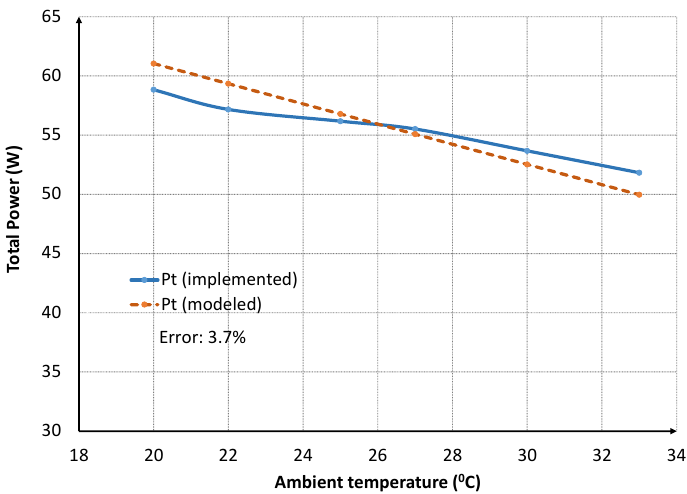
Figure 10. The measurement result of total power following various ambient temperatures.